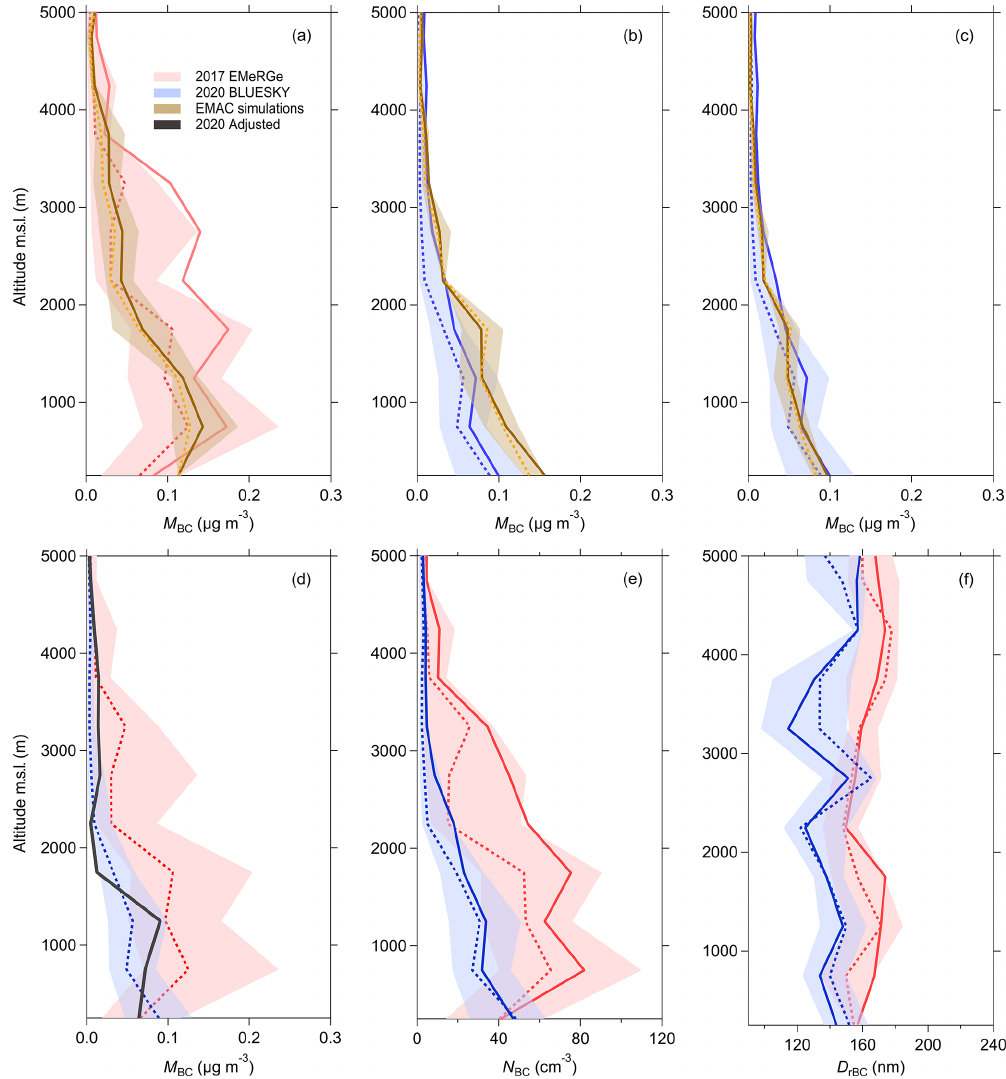
Figure 4. Vertical distributions of measured and modelled M BC (a, b, c, d) . Solid lines represent arithmetic mean values; dashed lines represent median values shading marks the interquartile range. Panel (a) shows EMeRGe EU 2017 measurements and EMAC simulations with initial 2014 emission inventories. Panel (b) shows BLUESKY 2020 measurements and EMAC simulations with initial 2014 emission inventories. Panel (c) shows BLUESKY measurements and EMAC simulations with anthropogenic BC emission reduced by 40%. Panel (d) shows EMeRGe EU and BLUESKY measurements (as also shown in panels a and b ) for comparison between the two campaigns. The grey solid line shows the adjusted median M BC concentration expected for BLUESKY measurements in 2020 (for details see Sect. 2.4). The adjusted value is based on non-confinement influences retrieved from the difference in the EMAC simulations for BLUESKY and EMeRGe EU with the 2014 emission inventories. It represents the expected measurement value, assuming the same meteorological and seasonal conditions for both campaigns. The difference between the medians of EMeRGe EU and adjusted BLUESKY represents the emission reduction. Panel (e) shows the measured N BC for EMeRGe EU in 2017 and BLUESKY in 2020. Panel (f) shows the geometric mean refractory BC core diameters ( D rBC ) for EMeRGe EU in 2017 and BLUESKY in 2020. Further details about the vertical distributions are in Sects. A3 and Supplement Sect.